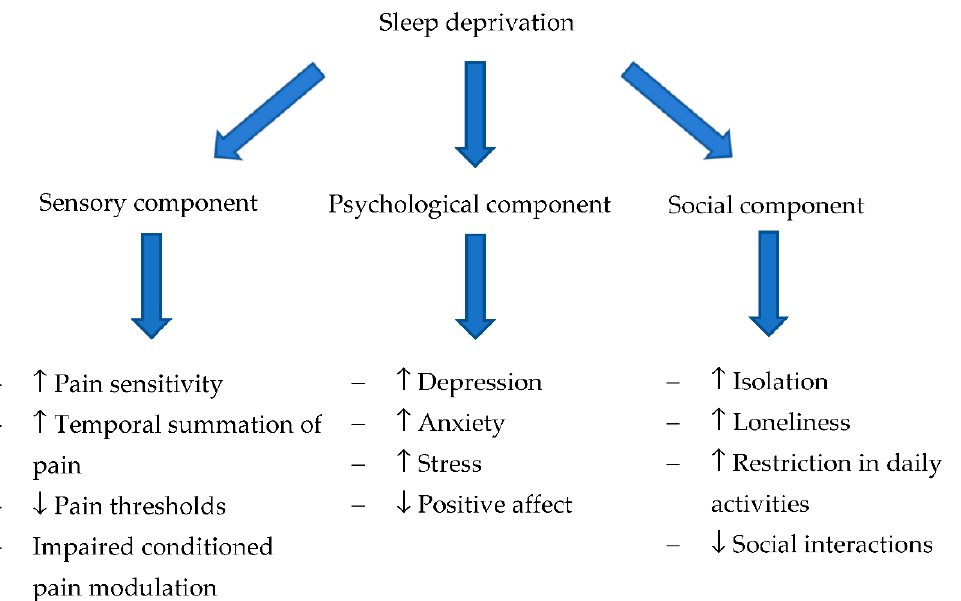
Figure 1. Effects of sleep deprivation on sensory, psychological, and social components involved in the transition to chronic pain. ↑ = Increased; ↓ = Decreased.